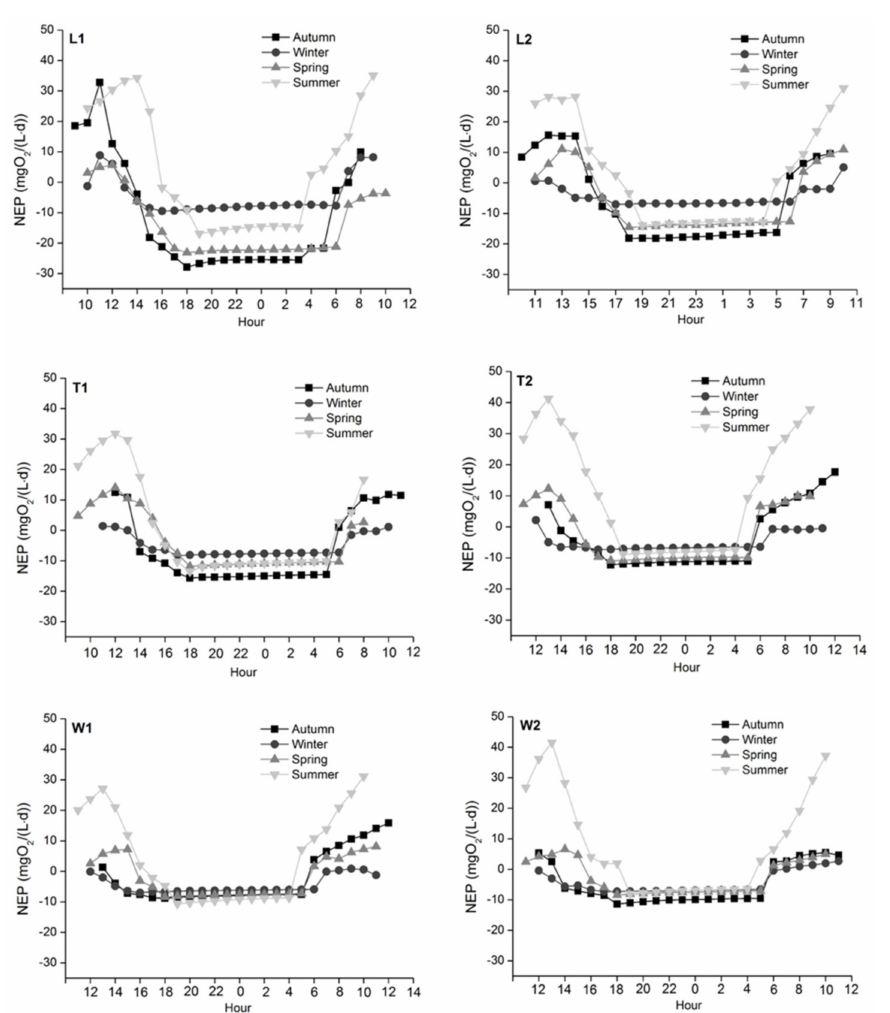
Figure 8. Diurnal variations of NEP in the four seasons across study sites. NEP decreased to the lowest value within one hour after sunset and then gradually increased. The maximum mean NEP with positive values appeared in summer among all sites, and the minimum values were observed in autumn except